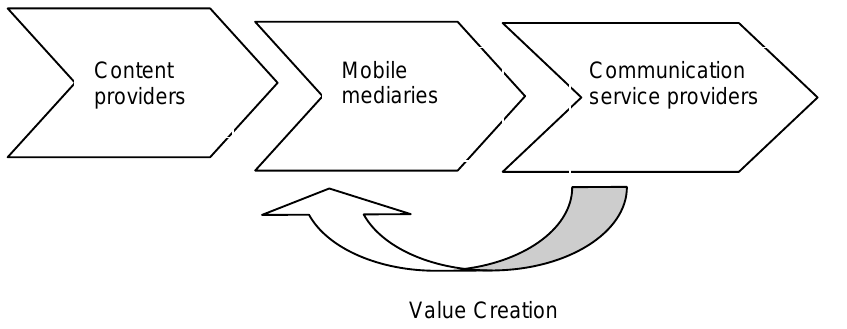
Figure 1: Market Players and Value Creation Beyond